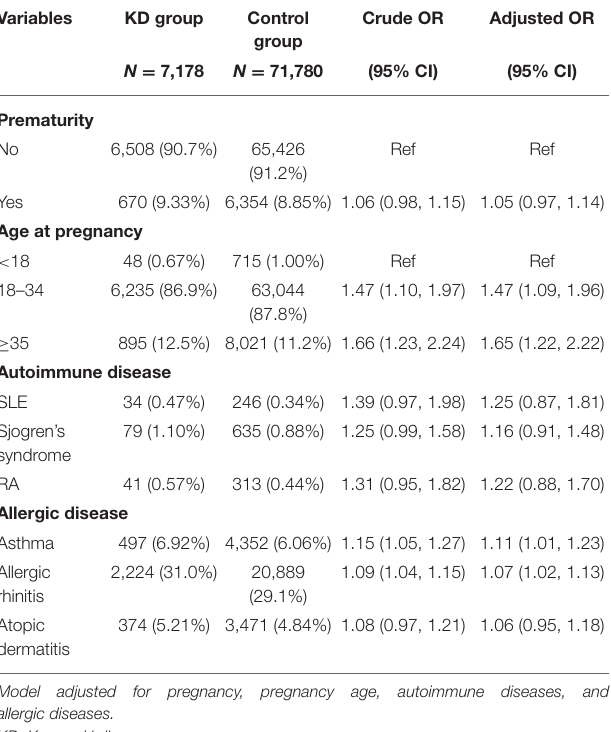
TABLE 1 | Demographic data of patients with KD and the control group. Variable